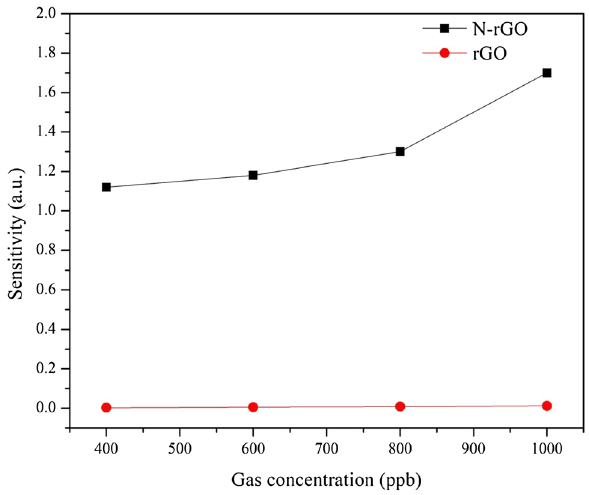
Figure 10. Sensitivity of rGO and N-rGO sensors to NO concentrations ranging from 400 to 1000 ppb at room temperature.